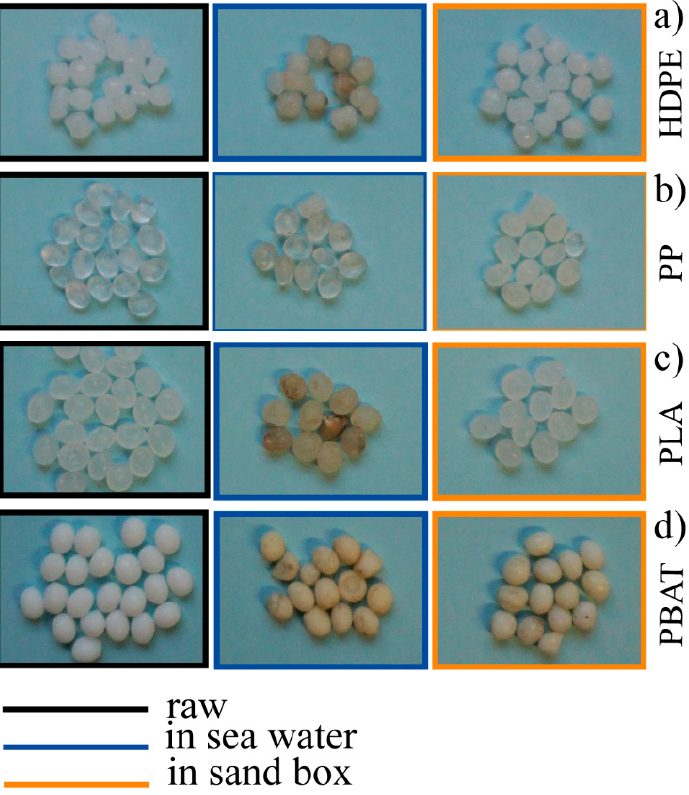
Figure 3. Digital photos of the raw pellets (in black), 6-months-aged in seawater (in blue) and 6-months-aged in sandbox (in orange). ( a ) HDPE, ( b ) PP, ( c ) PLA and ( d ) PBAT. A colour deviation towards yellow/amber was apparent. For all kinds of granules considered in this experiment, this was much more pronounced in the sea samples. In